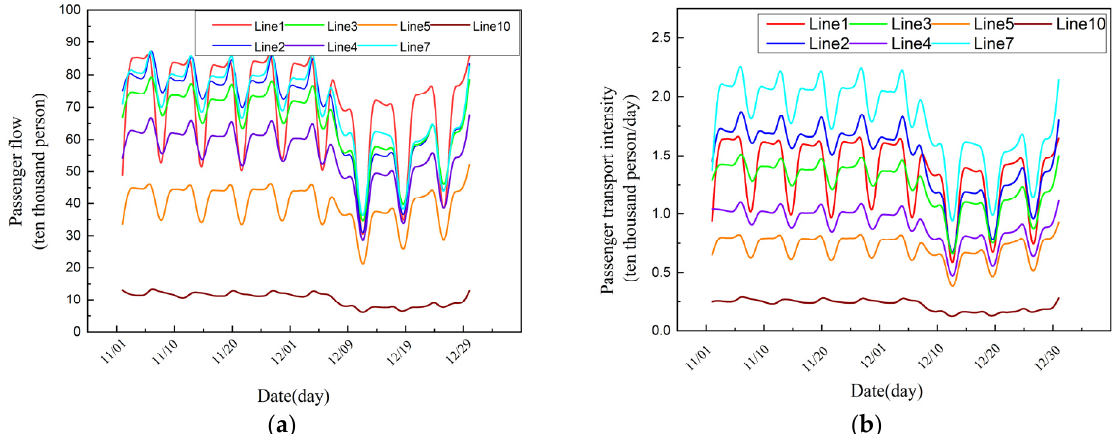
Figure 6. The real-time passenger flow ( a ) and passenger transport intensity ( b ) of the Chengdu rail transit network from 1 November to 30 December 2020. transit network from 1 November to 30 December